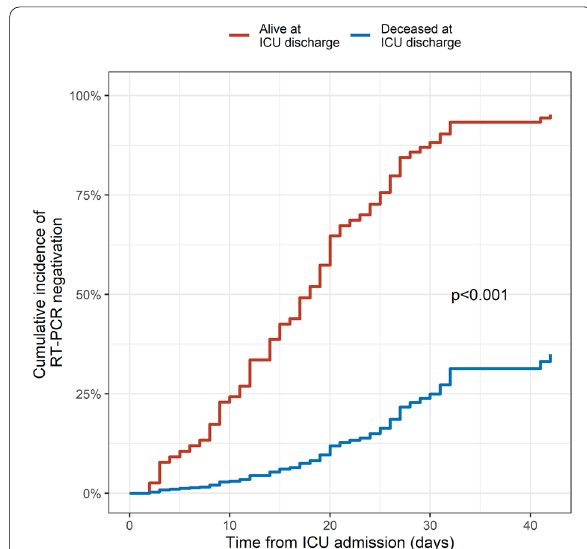
Fig. 3 Multivariate fine and gray competitive risk regression. The model predicts the cumulative incidence of RT‑PCR negativation following ICU admission. The curves represent multivariate model fit in patients deceased in ICU (blue lines) and in patients alive at ICU discharge (red lines). ICU intensive care unit, RT-PCR real‑time reverse